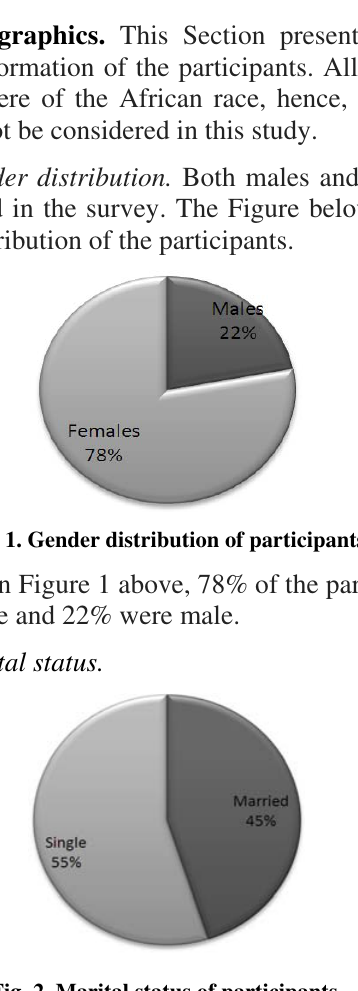
Fig. 2. Marital status of